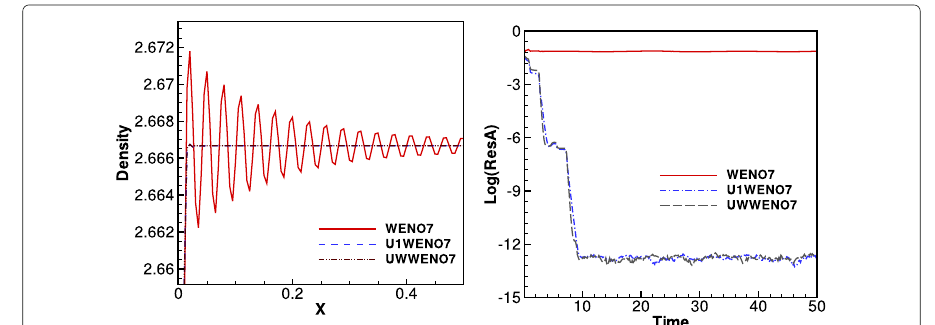
Fig. 8 Reproduced from [13]. Numerical solution of the 1D steady shock wave with Mach number M ∞ = 2 using the seventh-order WENO scheme with the upwind-biased interpolation. Left: zoomed density distribution downstream of the shock wave. Right: the time evolution of the average